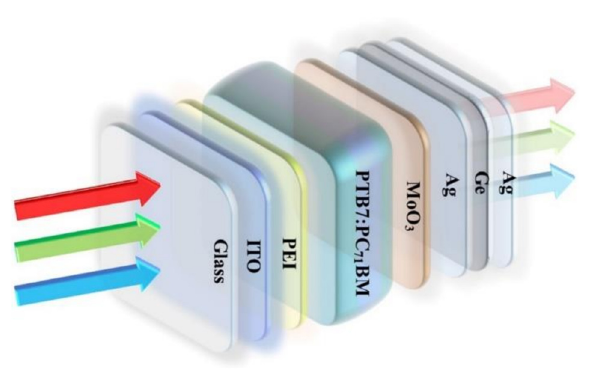
Figure 1. Structure diagram of PSCs with the Ag/Ge/Ag semitransparent